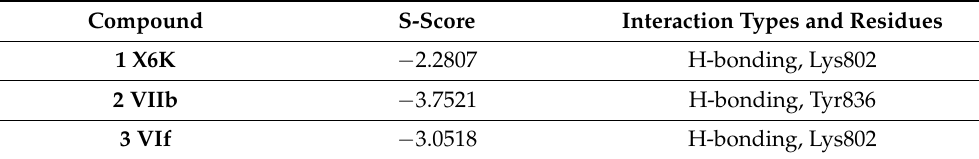
Table 7. The docking scores and the main H-bonds observed of the most active compounds against PI3K active site.